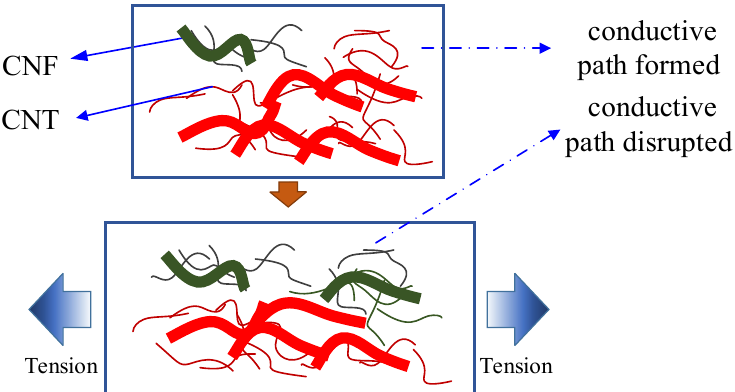
Figure 7. The piezoresistive sensing mechanism in the epoxy-base composites incorporating CNT–CNF under tensile loading.